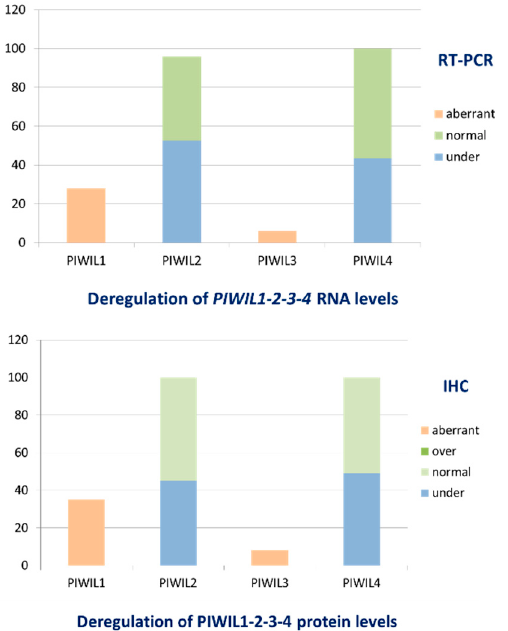
Figure 2. IBCs are characterized by deregulation of all proteins PIWIL1-2-3-4 at RNA and protein